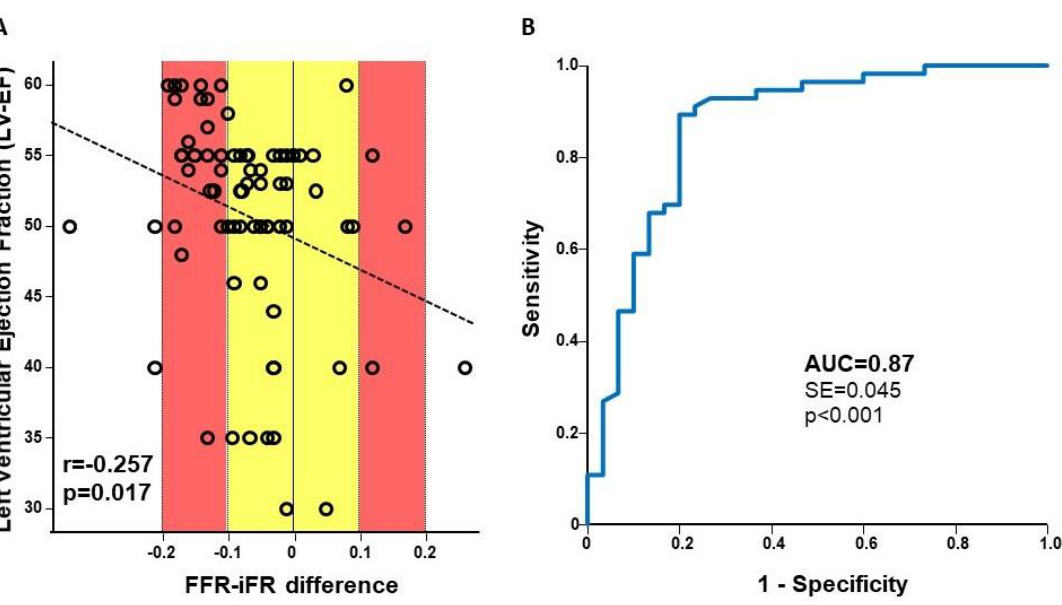
Figure 4. Impact of left ventricular function on the iFR. ( Panel A ) The discrepancy between measured values of the FFR and the iFR is inversely correlated to the left ventricular ejection fraction (LVEF). ( Panel B ) The correction of iFR measurement by LVEF improves its diagnostic performance.